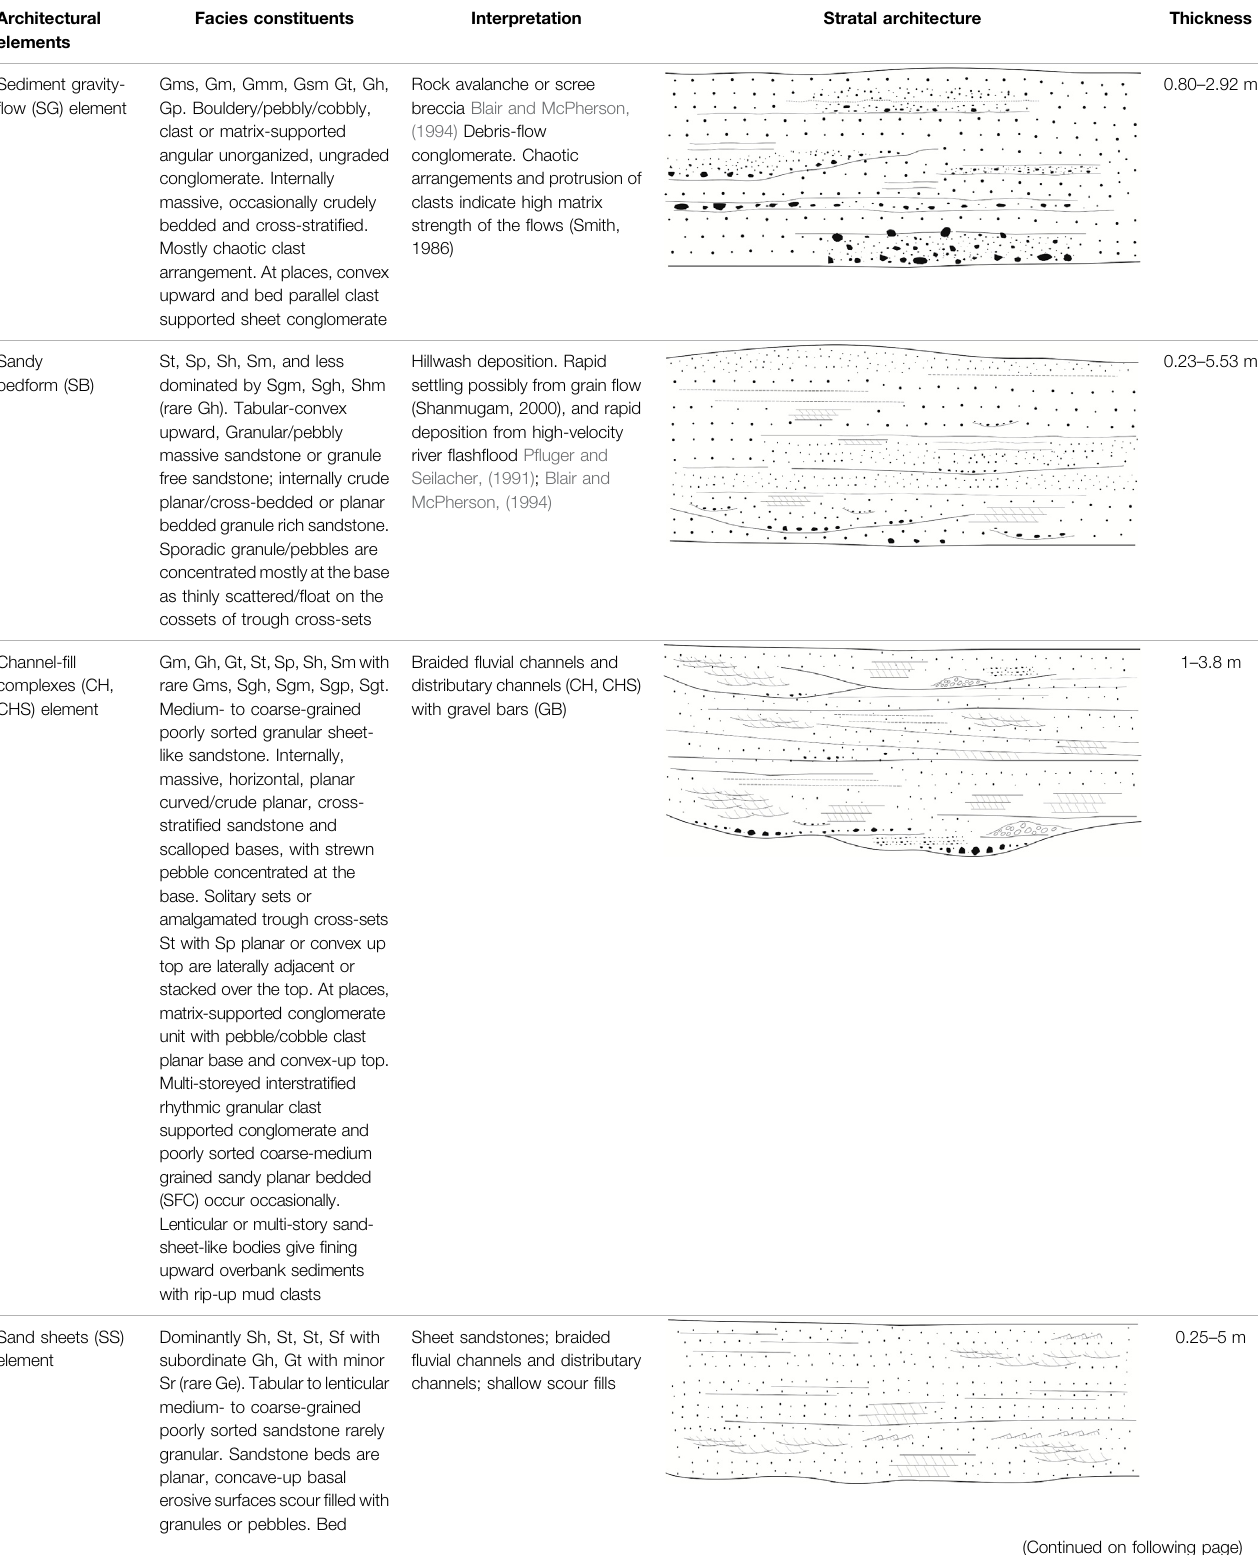
TABLE 1 | Architectural elements are described from alluvial deposits in Indian Precambrian